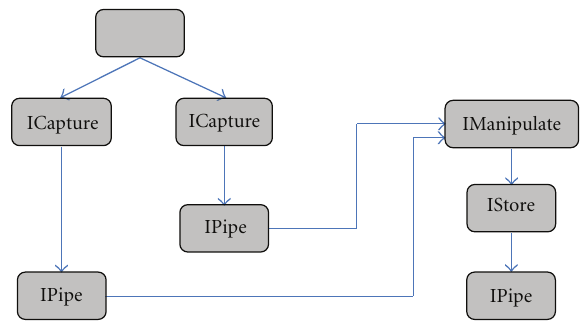
Figure 4: Main classes used in simulations.